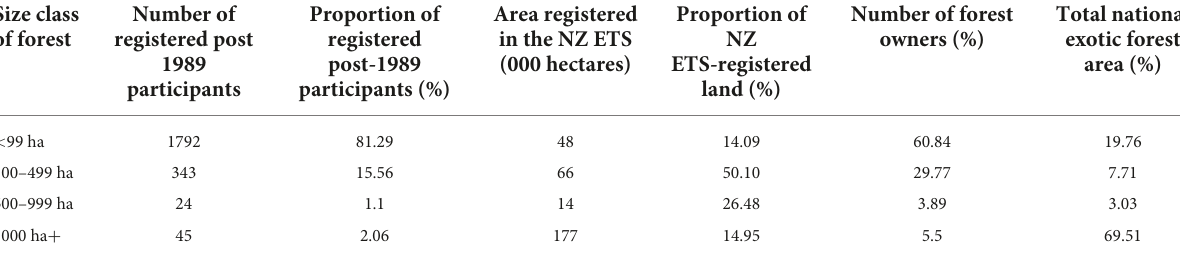
TABLE 3 Area and participants for post-1989 forest land registered in the NZ ETS by forest size class as of April 2016. Size class of